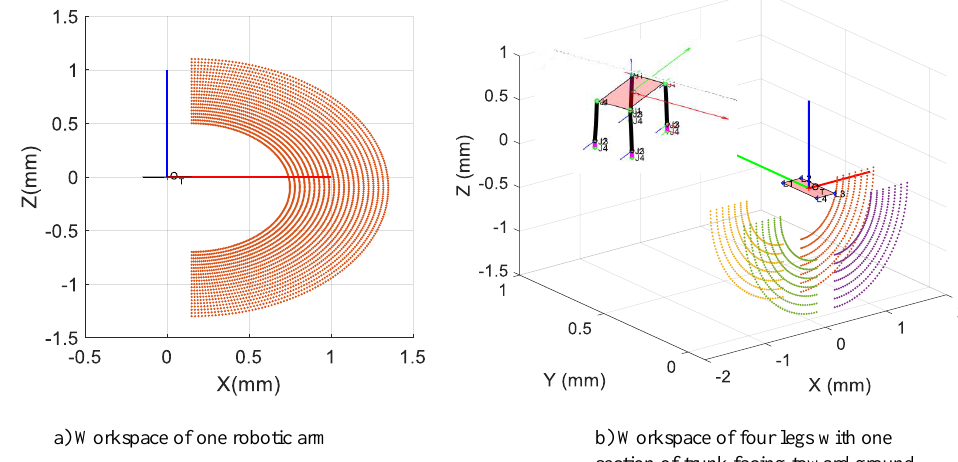
Figure 9. Graphical representation of the workspace of